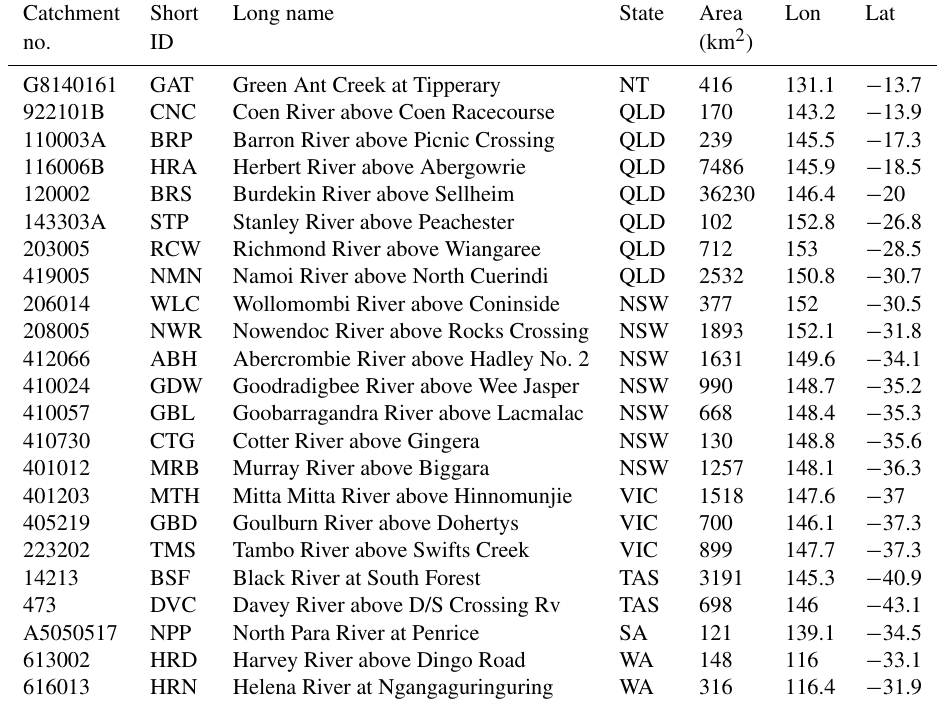
Table 1. Catchment information for the 23 forecast